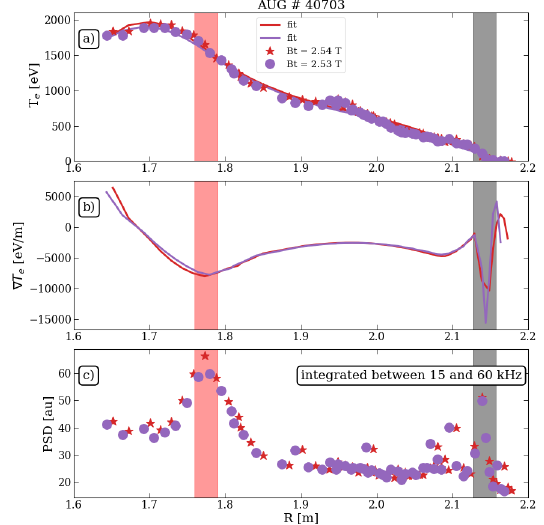
Figure 3. AUG #40703 with changing magnetic field; 2.53 T in magenta and 2.54 T in red a) The electron temperature profiles, b) the gradient of the electron temperature, c) amplitude distribution integrated between 15 and 60 kHz corresponding to the quasi- coherent mode